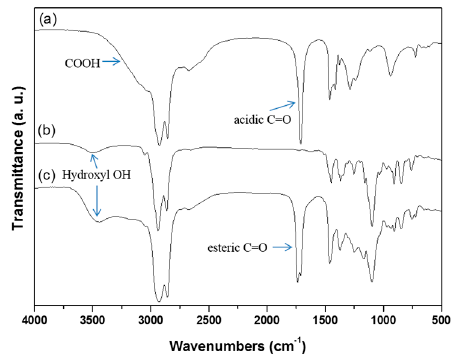
Figure 3. FT-IR spectrum of ( a ) the fatty acid, ( b ) ST-3000, and ( c ) the fatty acid-modified hydrogenated epoxy polyol (FMEP). epoxy polyol